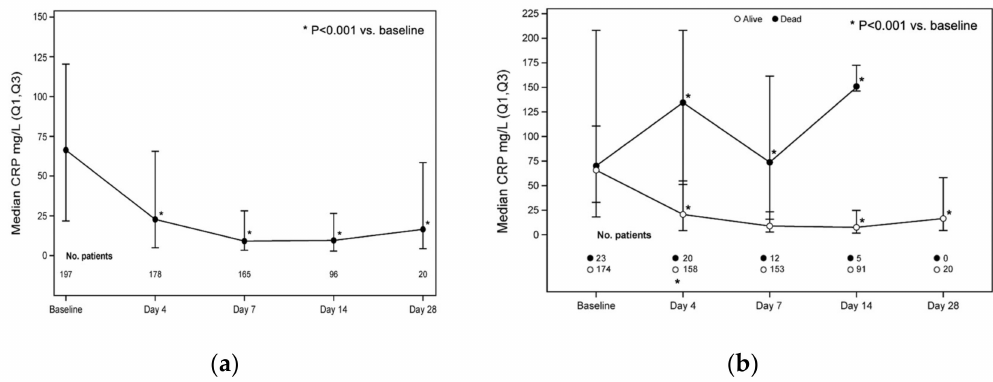
Figure 3. CRP levels at each time point: ( a ) p < 0.0001 at days 4, 7, and 14; p = 0.0014 at day 28; ( b ) correlation between CRP level and mortality at day 4: odds ratio 1.02, 95% CI 1.01–1.03, p < 0.0001 (Wilcoxon signed rank test).